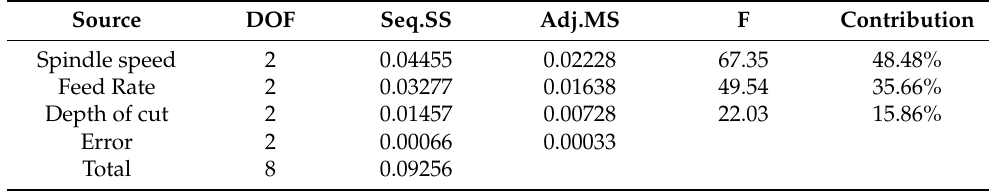
Table 6. ANOVA analysis for surface roughness of 0 ◦ PCD tool.